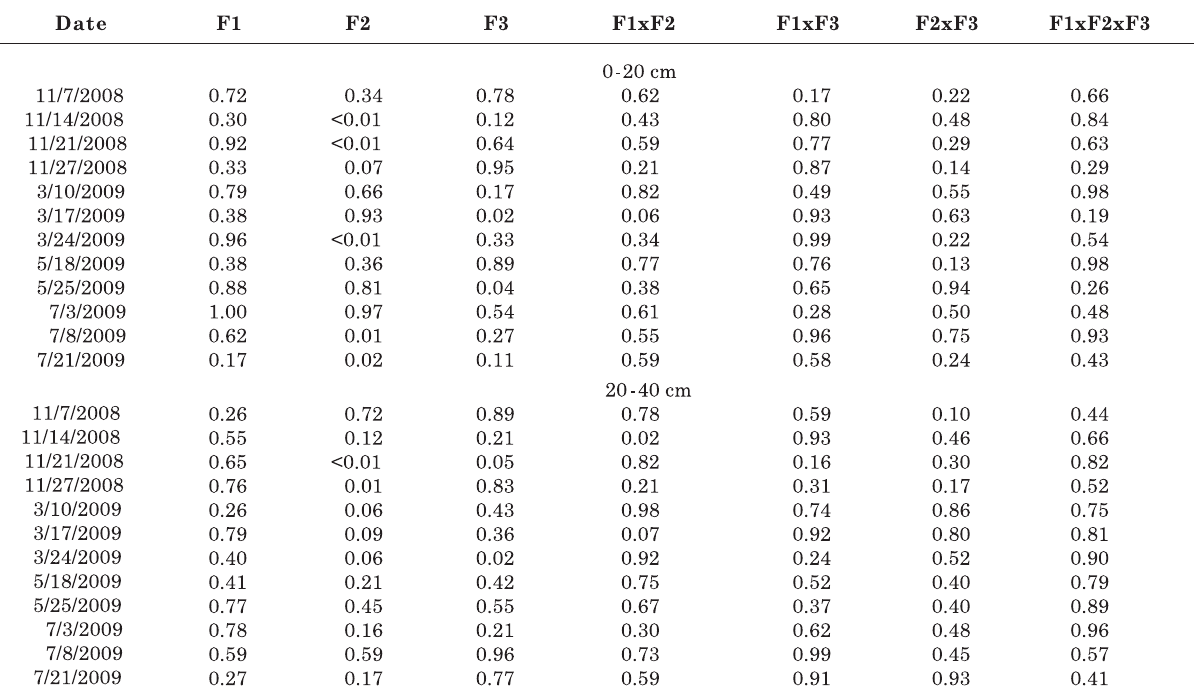
Table 4. Probabilities by the F test of the factors of variation F1 (soil tillage systems), F2 (mulch